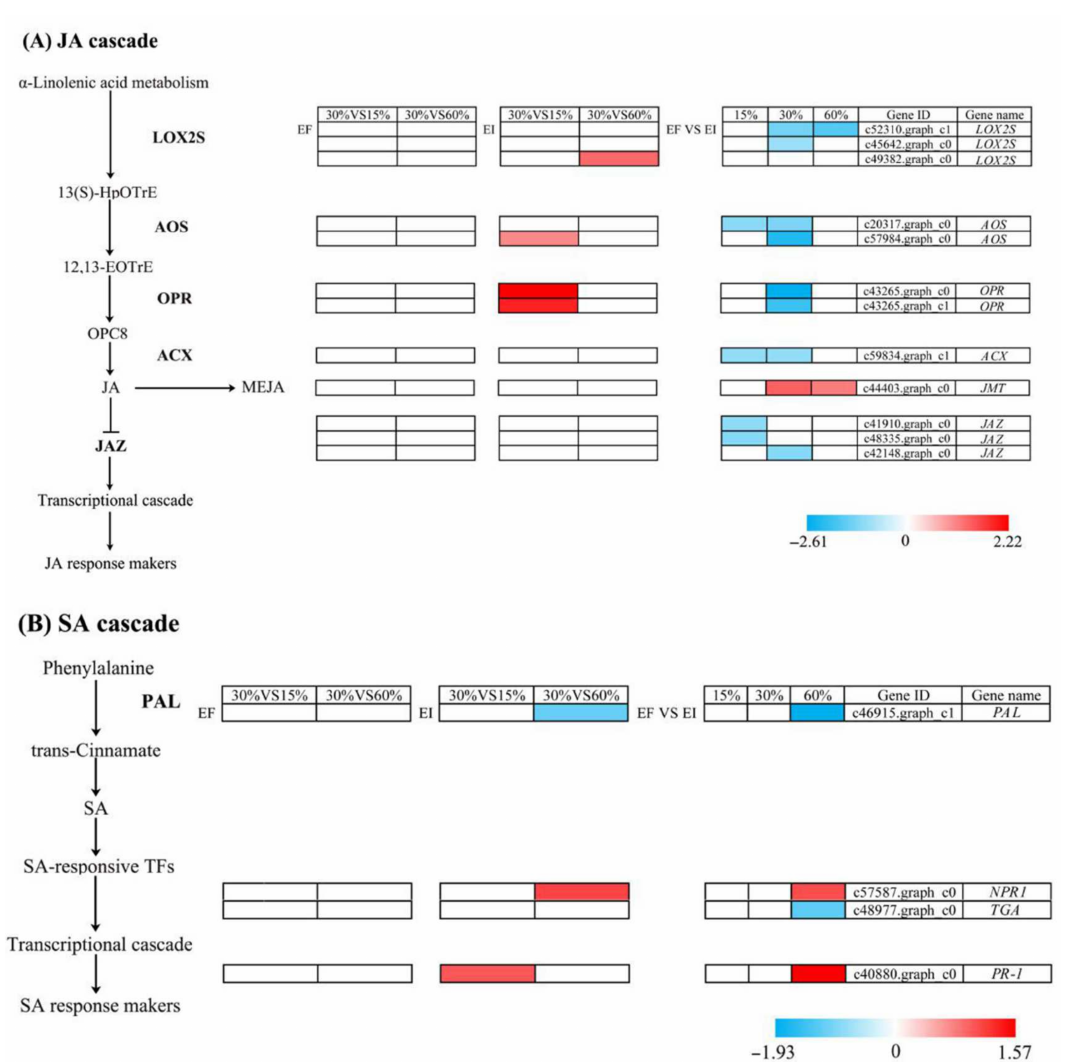
Figure 6. The cascade displaying synthetic and metabolic pathways of jasmonate ( A ) and salicylic acid ( B ) in Achnatherum inebrians under different moisture content and the status of foliar Epichloë gansuensis endophyte (EI: endophyte infected and EF: endophyte free). Color bars ranging from blue to red represent downregulation and upregulation in transcript expression. Gene ID and gene names are